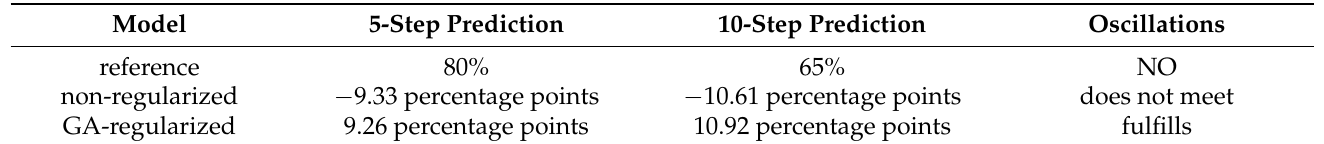
Table 5. Percent improvement of the prediction ability of the tuned model, compared to the reference values guaranteeing MPC controller performance and non-regularized model prediction ability.